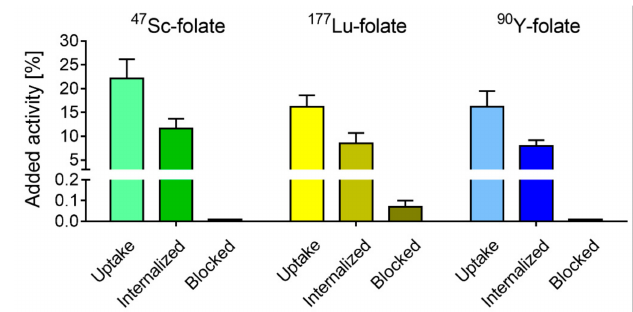
Figure 1. IGROV-1 tumor cell uptake and internalization of 47 Sc-folate, 177 Lu-folate, and 90 Y-folate after 4 h incubation. Blockade of the folate receptor (FR) by co-incubation of the IGROV-1 tumor cells with folic acid resulted in less than 0.1% uptake. The graph represents the average ± SD of three or four independent experiments performed in triplicate.